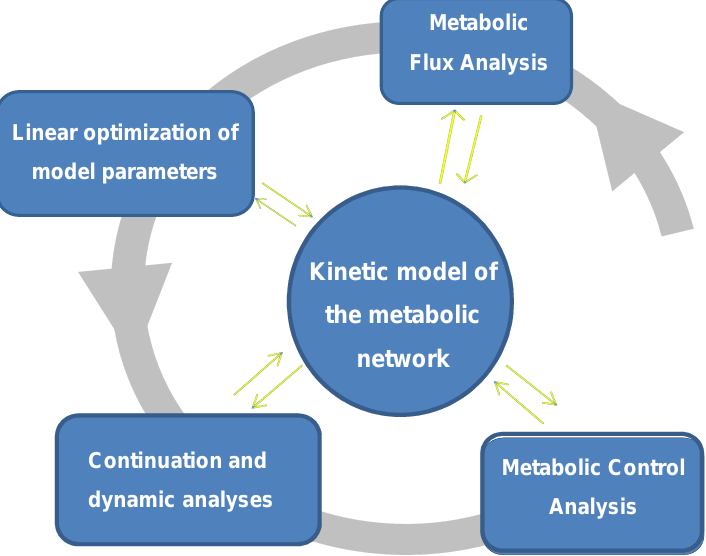
Figure 2. Integrated quantitative analytical approach of a computational model for translating metabolite profiles into metabolic fluxes. The method of Cortassa et al. (2015)